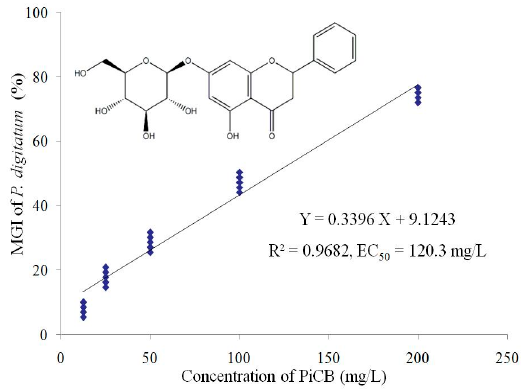
Figure 1. Linear regression analysis between pinocembroside (PiCB) concentration and mycelial growth inhibition (MGI) of Penicillium digitatum . The linear regression model ( Y = 0.3396 X + 9.1243) and coe ffi cient of determination ( R 2 = 0.9682) are shown. The chemical structure of PiCB as an inset is embedded in Figure